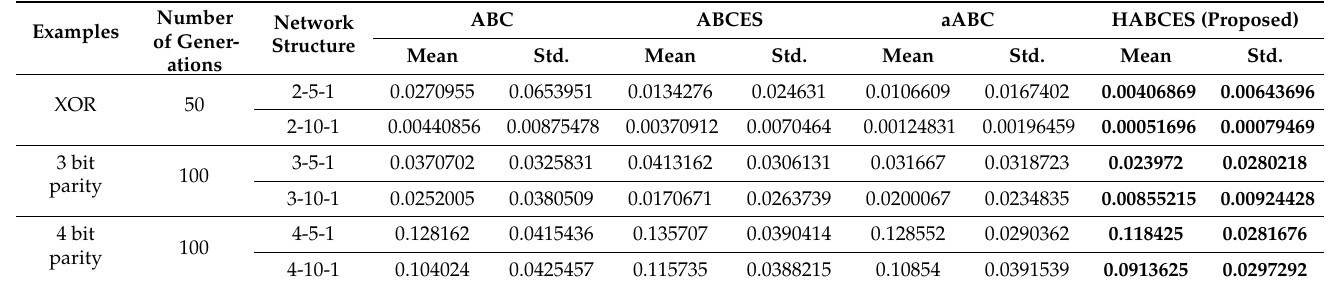
Table 4. Comparison of the results of the ABC, aABC, ABCES and HABCES algorithms when solving parity